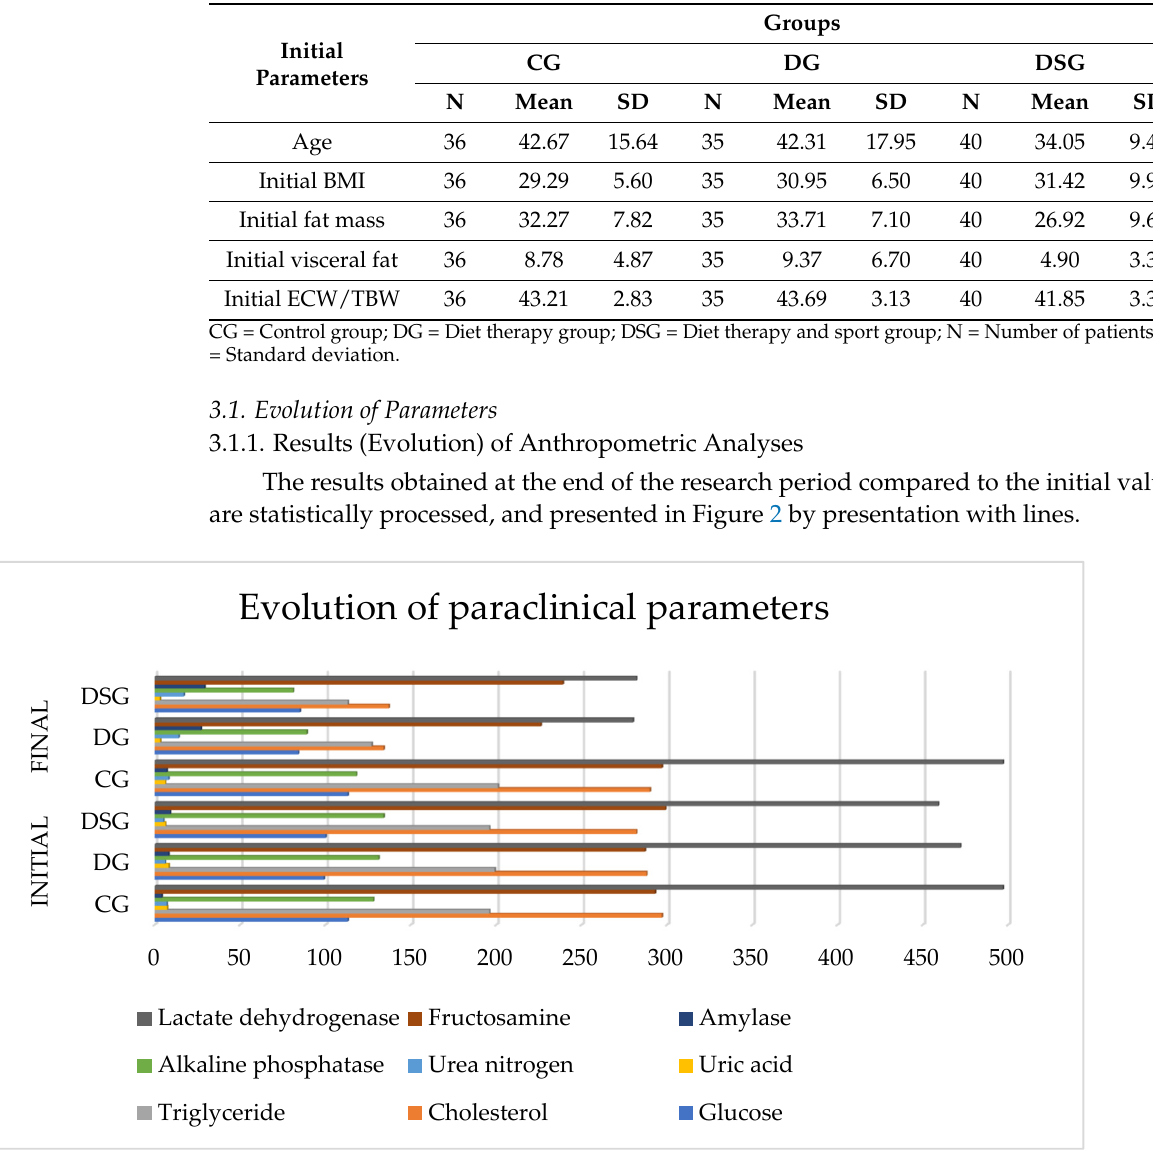
Table 2. Initial age and clinical parameters.